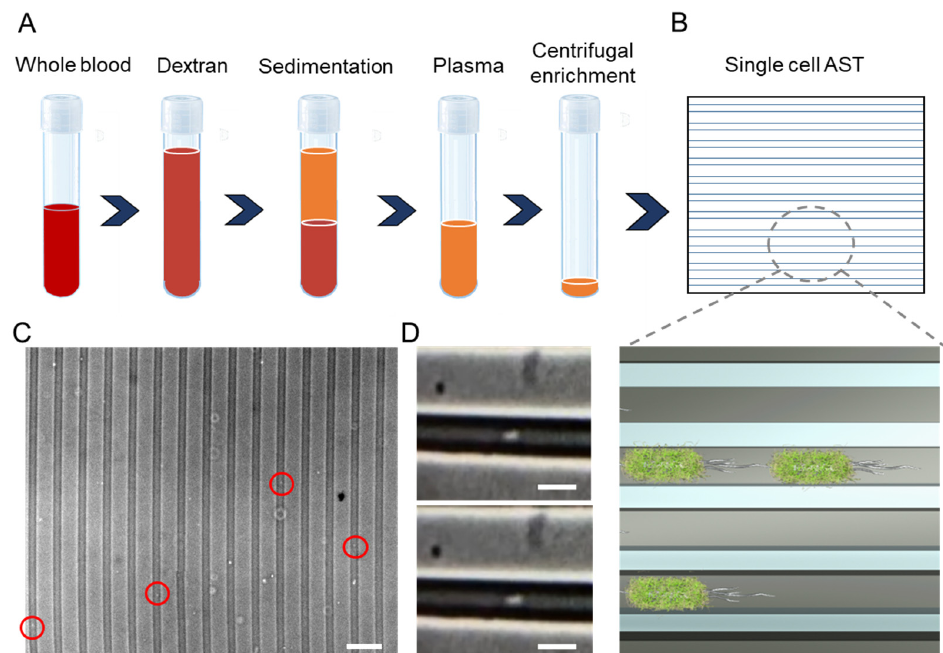
Figure 1. A workflow for rapid bacteria isolation from whole blood for single-cell AST. ( A ) Schematic of the sample preparation workflow with dextran sedimentation and centrifugation for single-cell AST of bloodstream infection. ( B ) Schematic of the microfluidic device for single-cell AST. (Bottom) Zoom-in view of bacteria trapped in the microchannel. ( C ) In the single-cell AST device, bacteria are trapped in the microscale channel for visualizing the presence of bacteria and their response to antibiotics. Scale bar, 20 µm. ( D ) Images of individual bacteria trapped in the microfluidic channel. Scale bars, 5 µm.